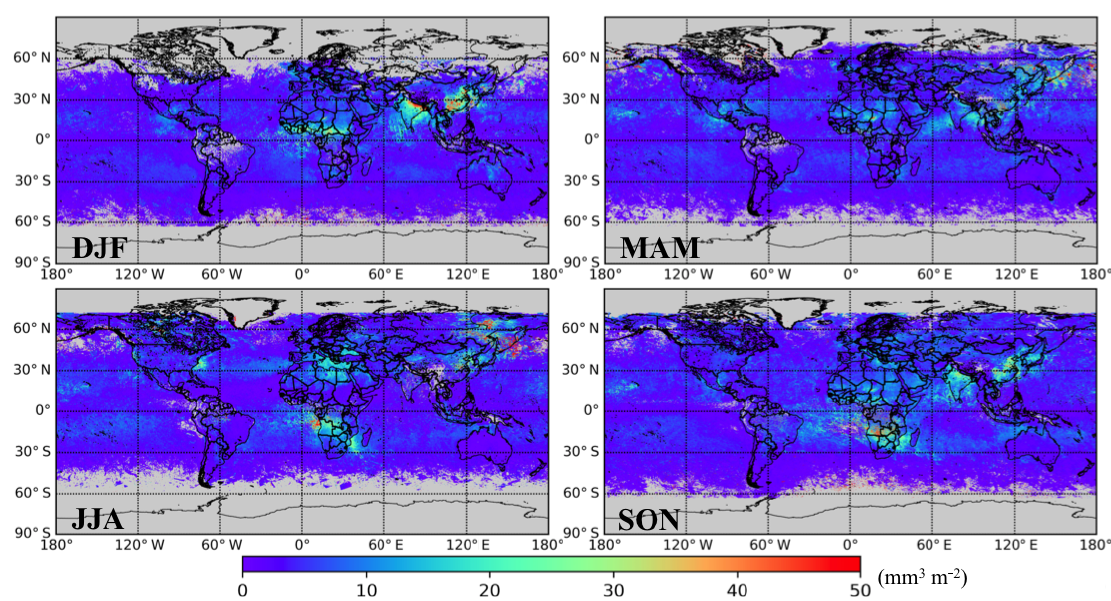
Figure 18. Same as Fig. 16, but for fine-mode non-absorbing soluble